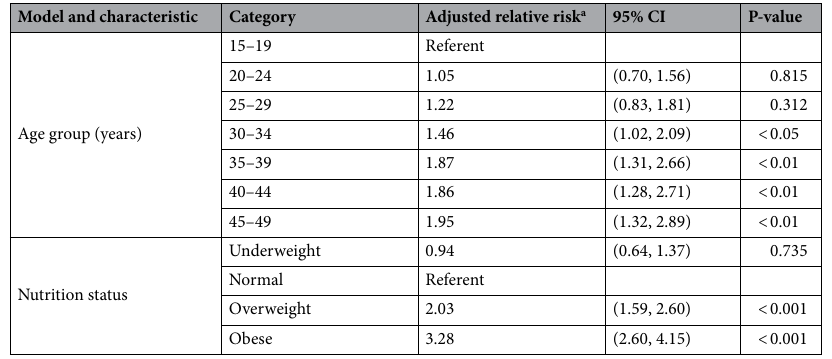
Table 4. Adjusted relative risk of diabetes, hypertension, obesity in non-pregnant women, The Gambia, 2018. a Calculated using relative risk from Poisson